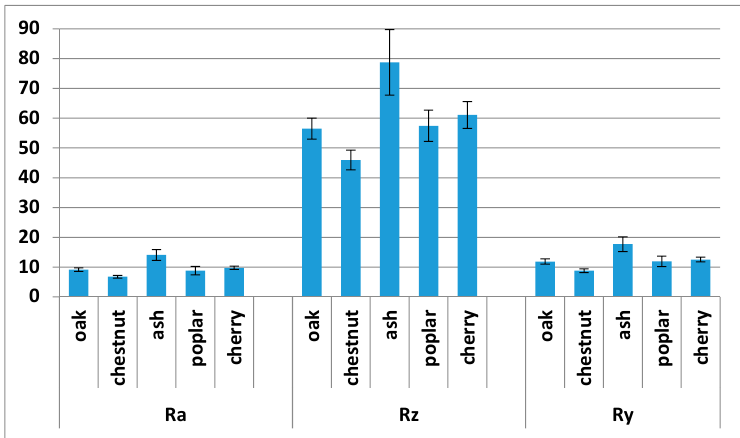
Figure 5. Mean values of surface roughness parameters Ra, Rz and Ry (µm), measured on typical wood structure areas of the sliced veneer sheets of the five different species studied.